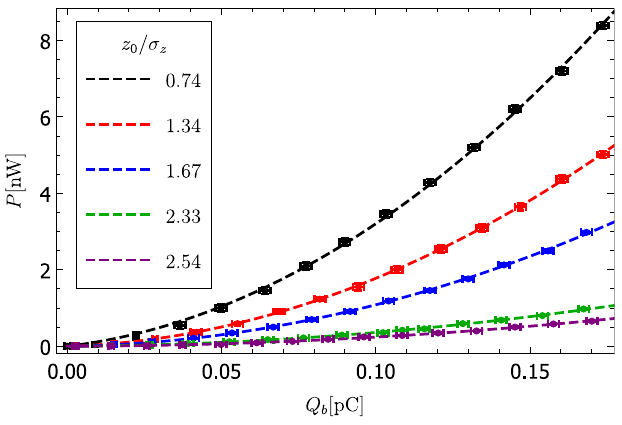
for different b